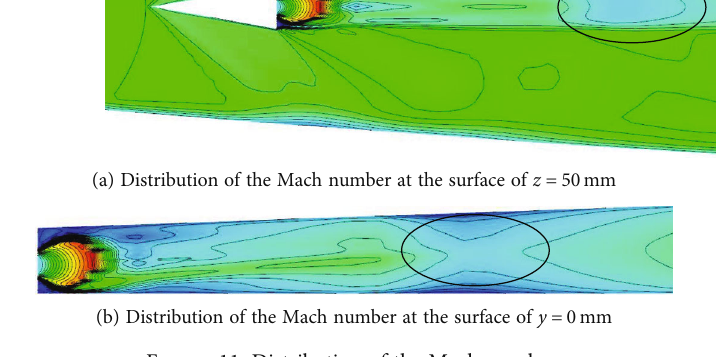
Figure 11: Distribution of the Mach number.